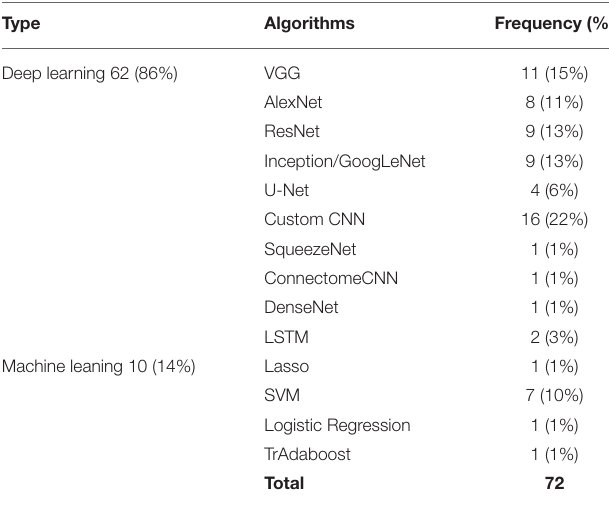
TABLE 4 | Machine learning vs. deep learning algorithms used for neuroimaging problems and their usage